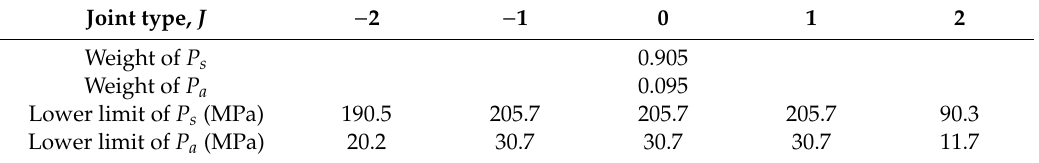
Table 9. Applicability constraints in multi-objective parameter optimization forvarious joint